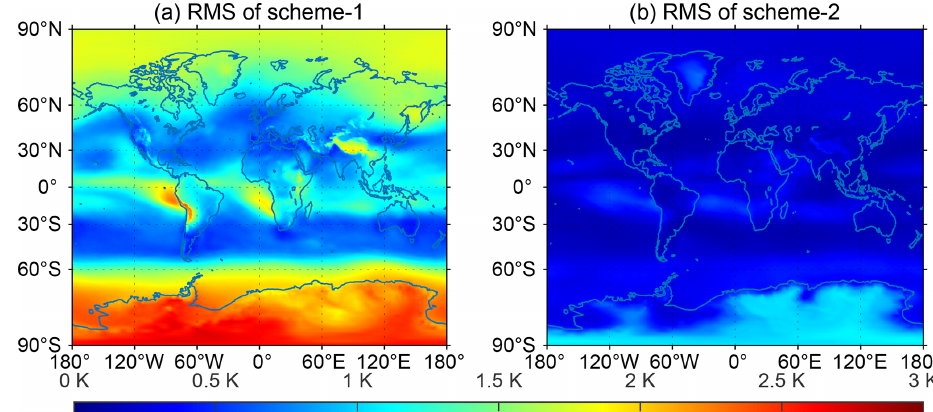
Figure 2. Mean of rms’s of the T m residuals of 120 monthly mean profiles from the 10-year period at each grid point for scheme 1 ( a , for linear function) and scheme 2 ( b , for three-order polynomial